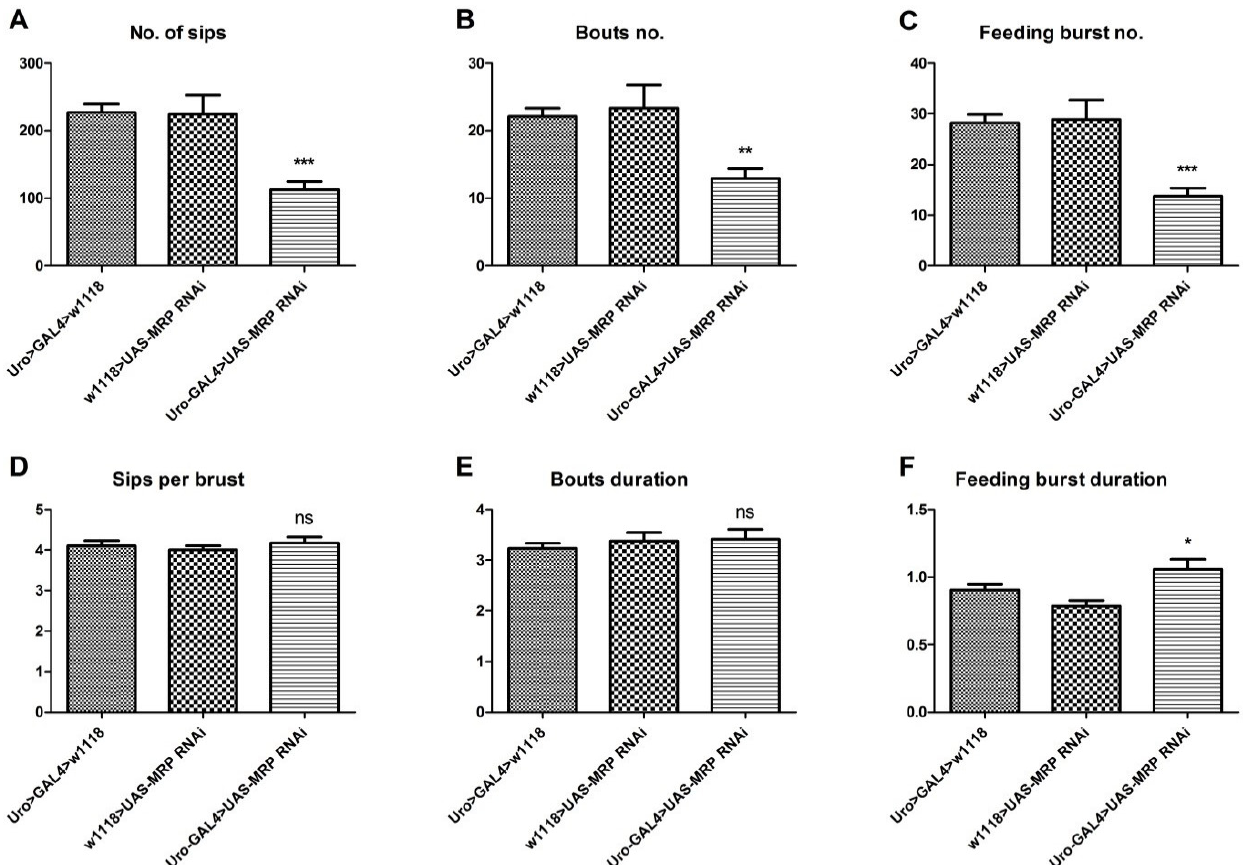
Figure 3. MRP knockdown in the Malpighian tubules affects feeding behavior. Male flies 5–7 days of age were used, and the flyPAD was employed to assess the feeding behavior. ( A ) The number of sips, which represents the total food intake; ( B ) the number of feeding bouts, which represents any interaction with food drop; and ( C ) the number of feeding bursts, which represents the number of meals, were all significantly decreased in the experimental group. However, both ( D ) the sips per burst and ( E ) bout duration were not affected. The feeding burst ( F ) duration was slightly increased in the experimental group. All graphs are presented as mean ± SEM, n = 32 males per group; ns, not significant; * p < 0.05, ** p < 0.01, *** p < 0.001; one-way ANOVA with Tukey’s post hoc test was performed; the experimental group was compared to each of the control groups.